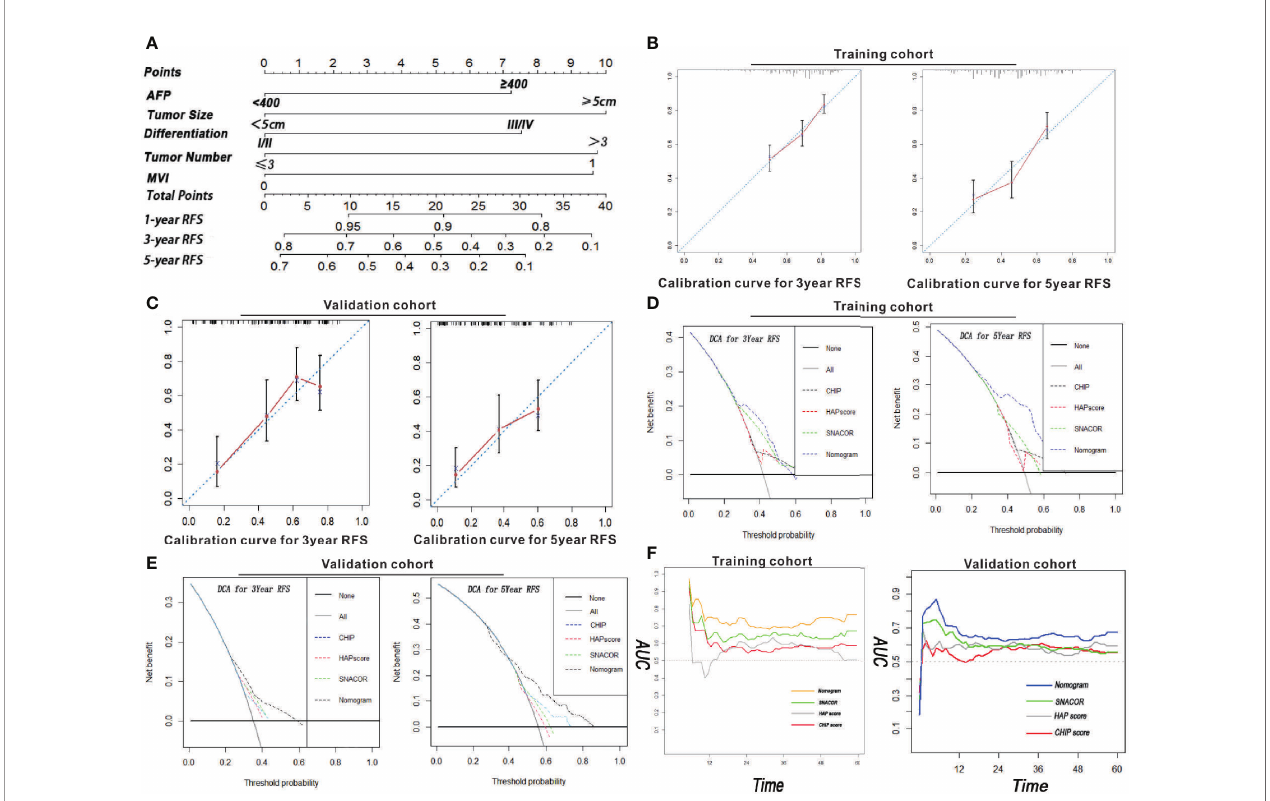
FIGURE 2 | Nomogram, calibration curve, decision curve, and time-dependent AUC analyses for HCC patients who received PA-TACE. (A) The novel nomogram constructed to predict RFS was generated by incorporating the variables of AFP, MVI, tumor number, tumor size, and differentiation. The 3- and 5-year calibration curves for predicting RFS in patients in both the training and validation cohorts are illustrated in Panels (B, C) . The DCA for the nomogram and common clinical staging systems were used to predict the clinical net bene fi t in comparison to the integrated nomogram, CHIP, HAP, and SNACOR scores in terms of 3- and 5-year RFS in both the training (D) and validation cohorts (E) . (F) A time-dependent AUC curve for our nomogram compared to CHIP, HAP, and SNACOR. Compared to the other systems, our nomogram showed the greatest prediction for recurrence in both training and validation